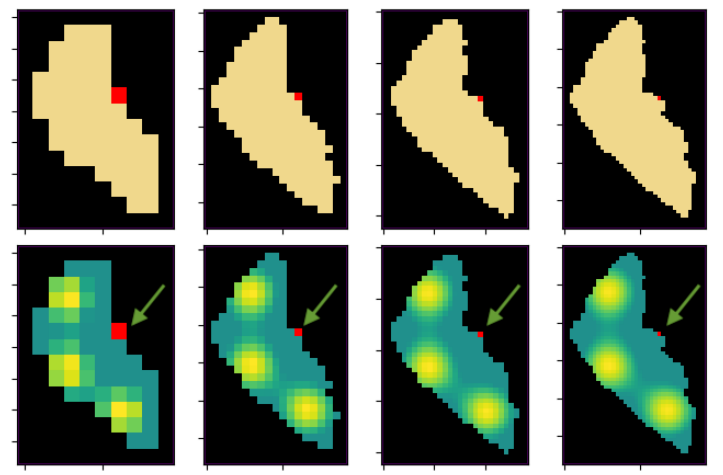
Figure 12. Different discretized maps of Ypacaraí Lake with N = × 1, × 2, × 3 and × 4 resolution. In red, the initial point of the